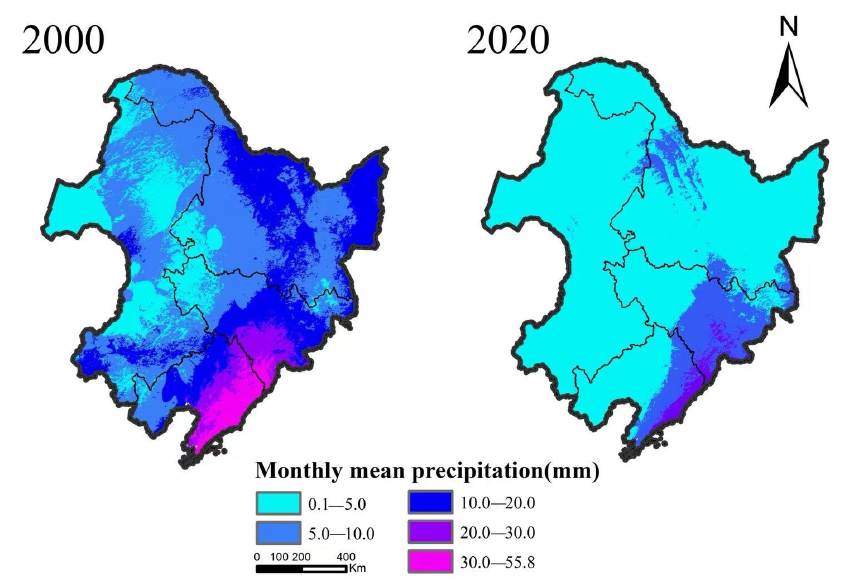
Figure 6. Monthly mean precipitation changes.